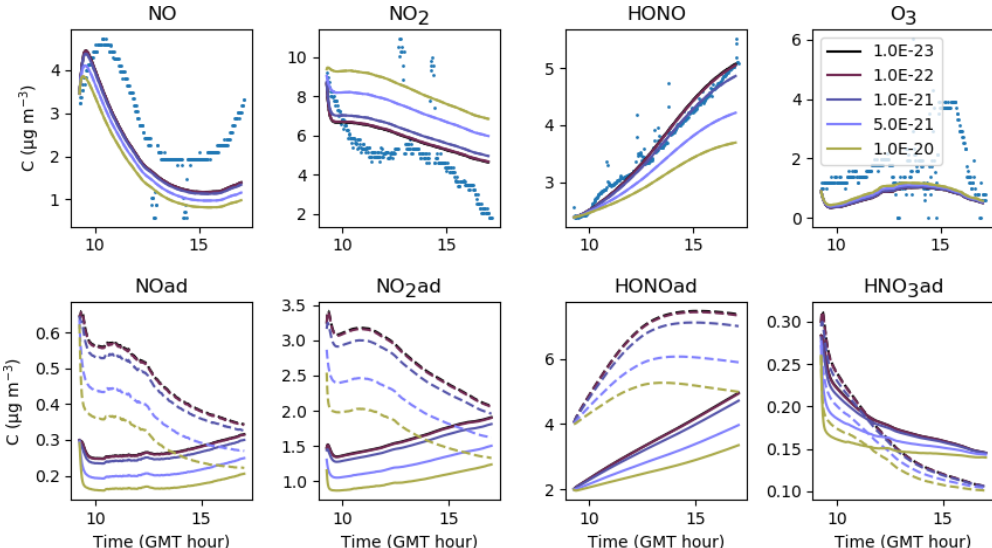
Figure 17. Gas-phase and adsorbed inorganic compounds simulated for different k (cid:48) ments (Experiment 3). The solid lines represent the concentrations in the sunlit box and the dashed lines the concentrations in the shaded box.